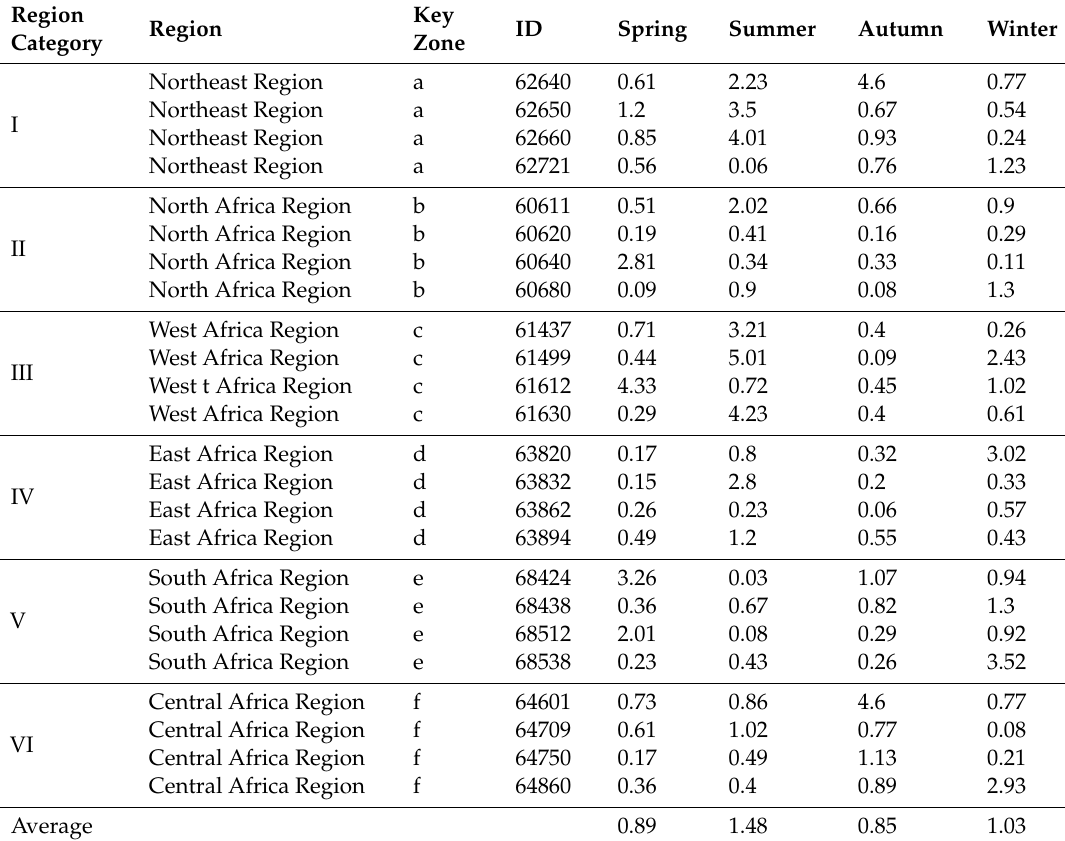
Table 2. The MAEs of the ground stations in six typical zones (Unit ◦